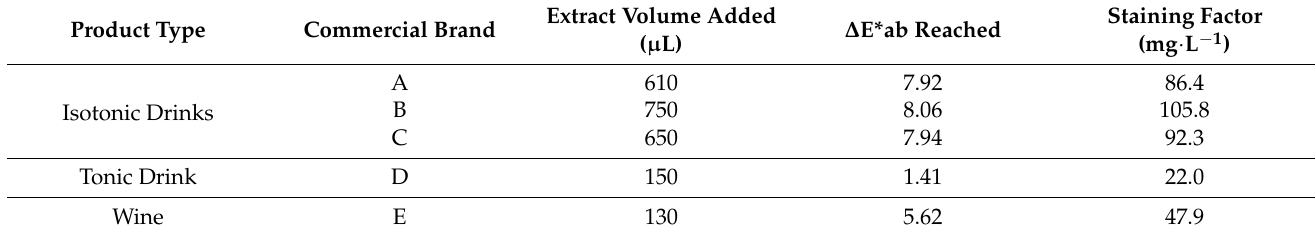
Table 2. Staining factors of the assayed beverages: data are obtained from the colouring curves of the products ([C-PC] extract = 2.08 mg/mL − 1 ).